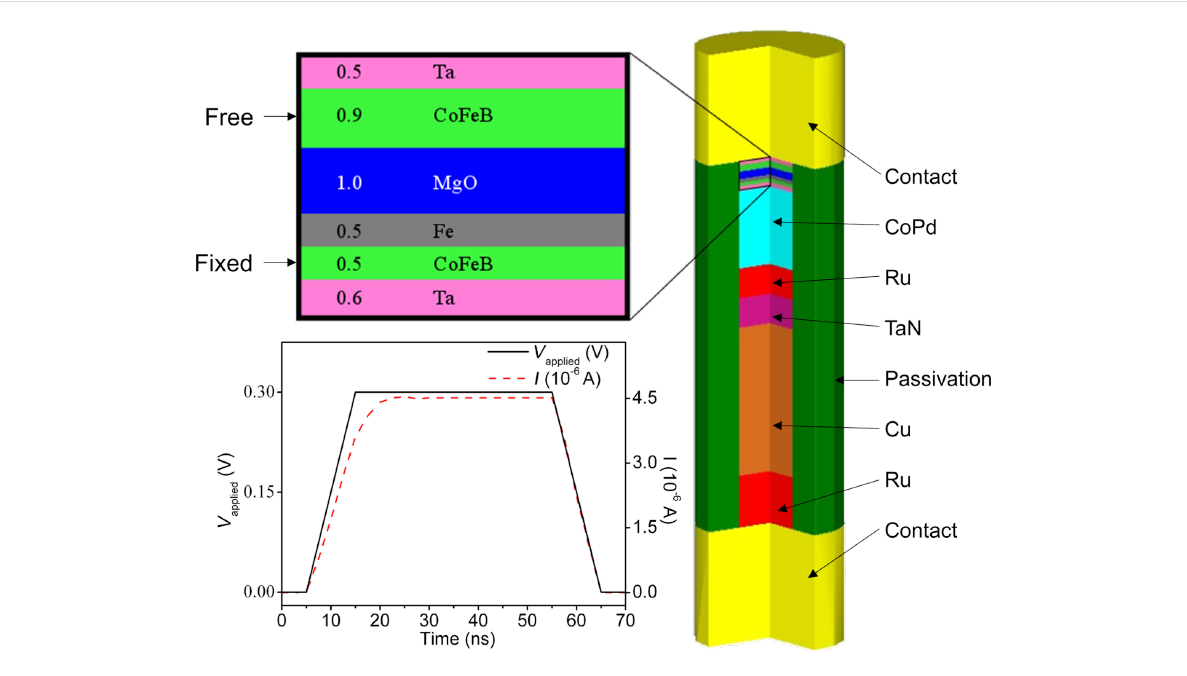
Figure 1: MRAM device structure with a stack radius of 10 nm. Materials, with exception of contact regions, are proportional to actual device model. The CoFeB–MgO–Fe–CoFeB MTJ is shown in the enlarged image, where the dimensions are given in nanometers. The inset shows the applied voltage and resultant current waveform for 0.3 V